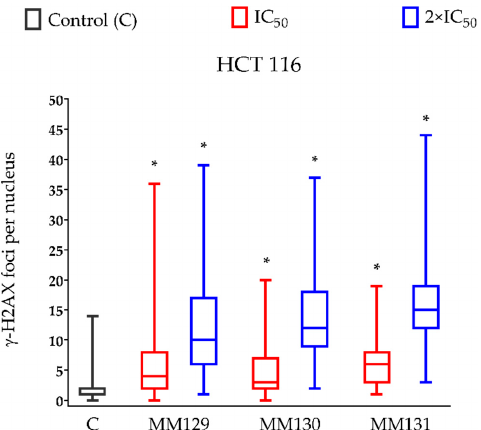
Figure 5. The presence of the γ -H2AX foci of DSBs per nucleus in HCT 116 cells treated with MM129 , MM130 , and MM131 for 24 h. The data are shown as a median of the number of γ -H2AX foci with interquartile range and minimal and maximal values. Significant differences ( p < 0.0001) compared with negative control (*).